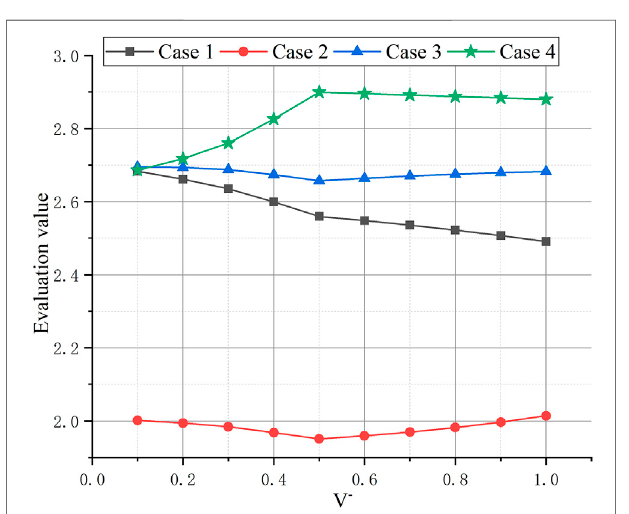
FIGURE 7 | The in fl uence of different V − on the dynamic evaluation results of each scheme when V + (cid:1) 1 .